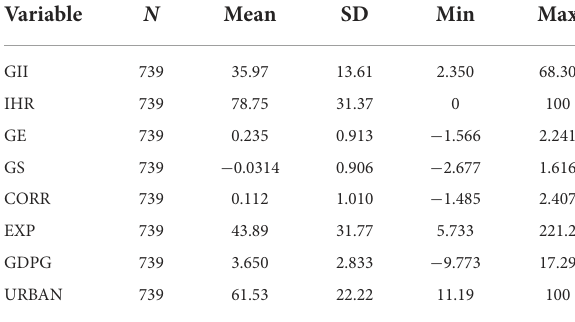
TABLE 1 Data description. TABLE 2 Summary